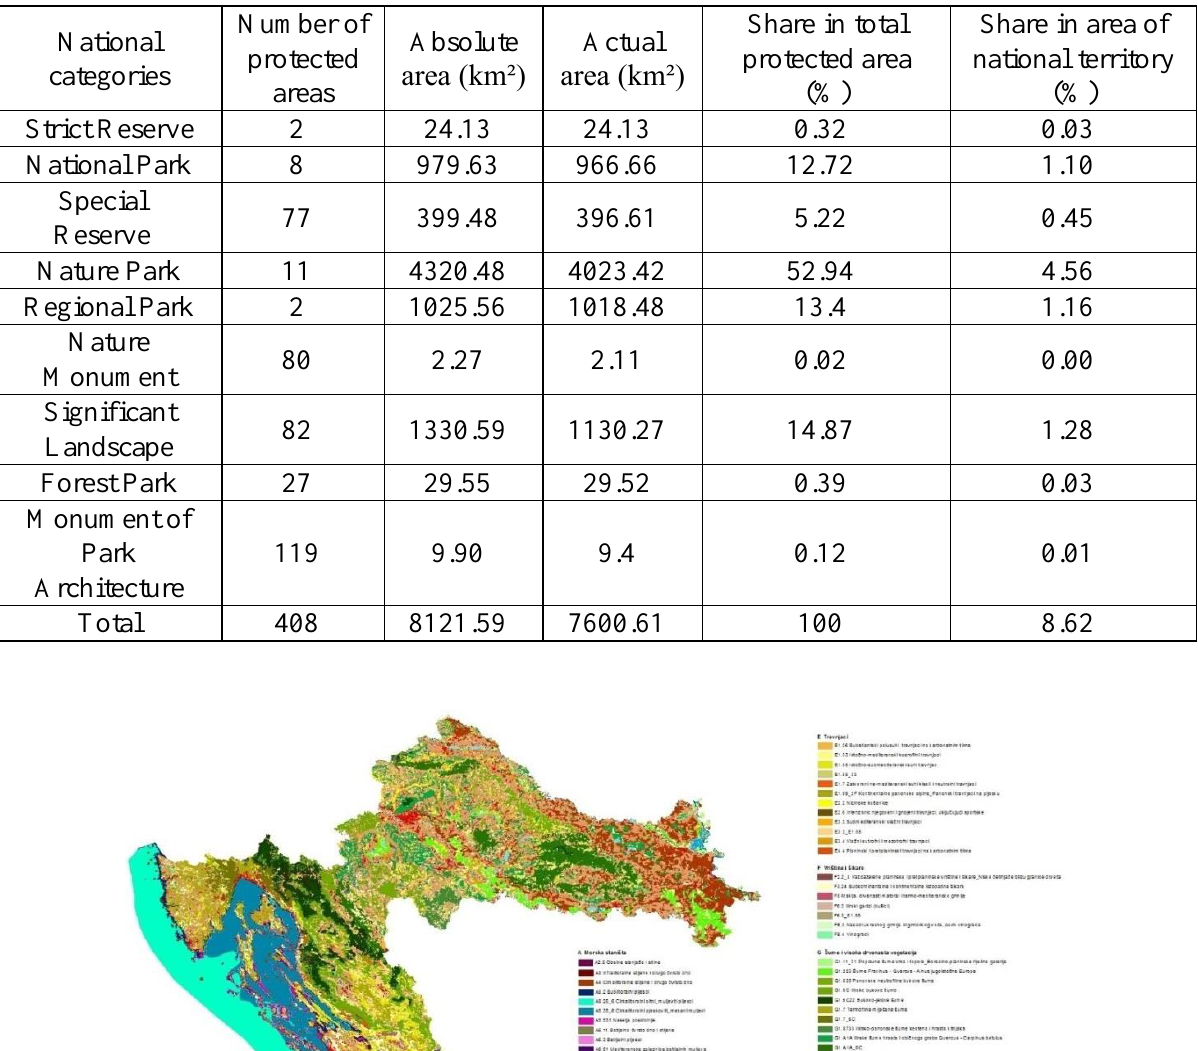
Table 1. Protected areas in Croatia [15 - 17]